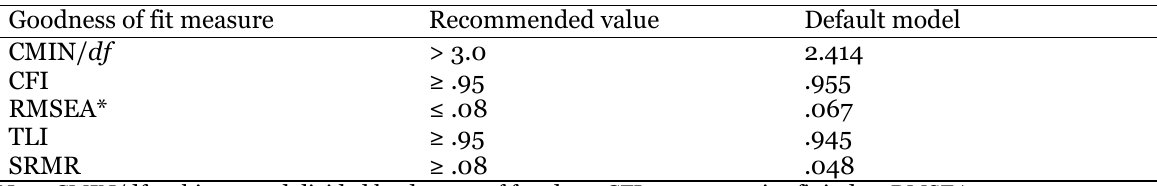
CFA Fit Indices for Measurement Model Goodness of fit measure Recommended value Default model CMIN/ df > 3.0 2.414 ≥ .95 .955 RMSEA* ≤ .08 .067 ≥ .95 .945 SRMR ≥ .08